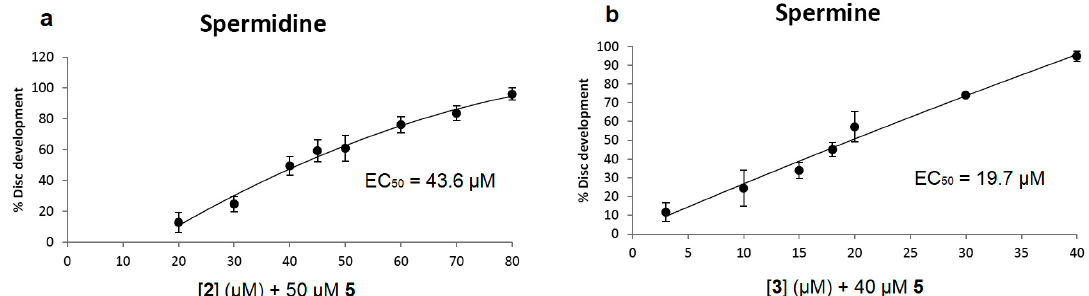
Figure 4. Spermidine and spermine block the inhibitory effect of Ant44 ( 5 ) on imaginal disc development. Spermidine ( 2 ) and spermine ( 3 ) were tested at different concentrations in the presence of Ant44 ( 5 ) and the percentage of imaginal disc development was recorded for each concentration.